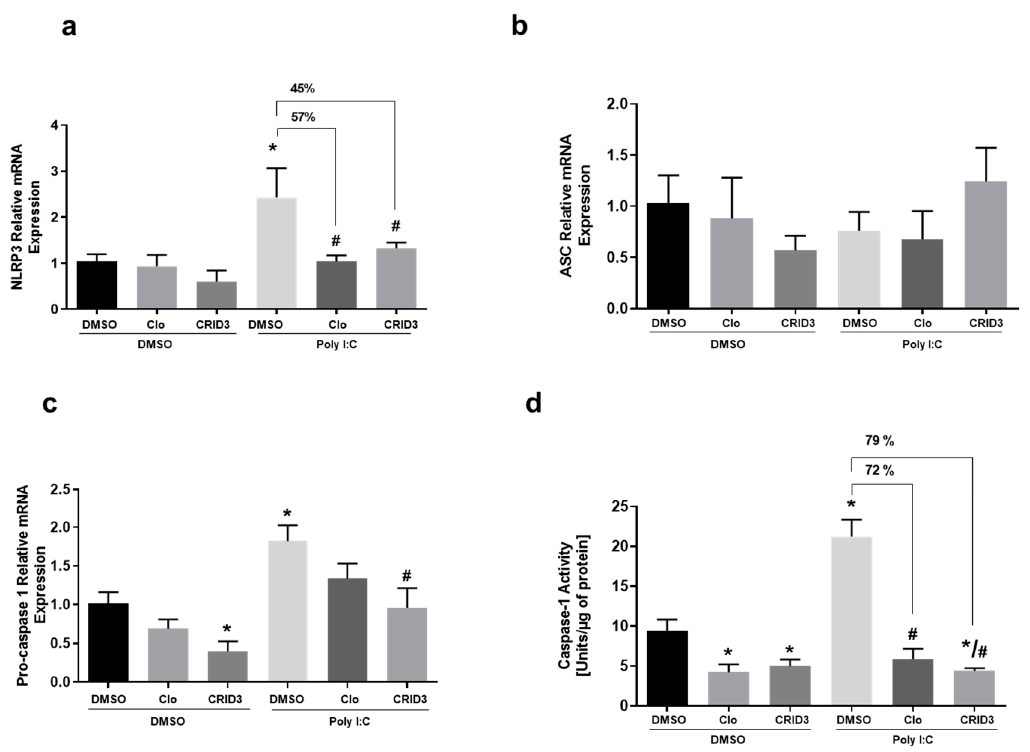
Figure 5. The effect of clozapine and CRID3 on poly (I:C)-induced inflammasomes: The effects of 10 μ M clozapine and 10 μ M CRID3 on the mRNA expression of ( a ) NLRP3, ( b ) ASC, ( c ) procaspase-1, and ( d ) Caspase-1 activity. The microglia were exposed to poly (I:C) (10 μ g/mL) and then immediately treated with clozapine (10 μ M) and CRID3 (10 μ M) for 24 h. The experiments were performed with each sample in triplicate. clozapine (CLO). The data is expressed as the mean ± SD of three independent experiments. * p < 0.05 vs. control samples. # p < 0.05 vs. poly (I:C)-treated samples.